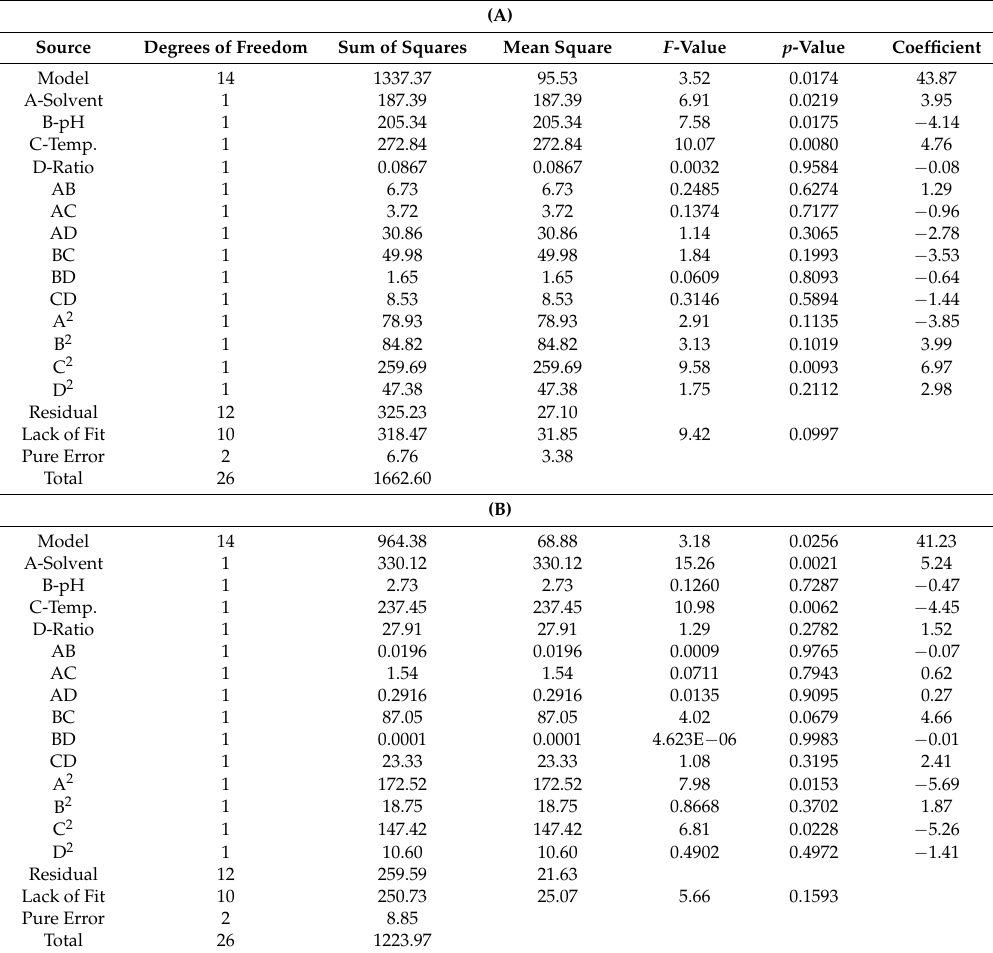
Table 2. Analysis of variance (ANOVA) for the response surface quadratic model of the